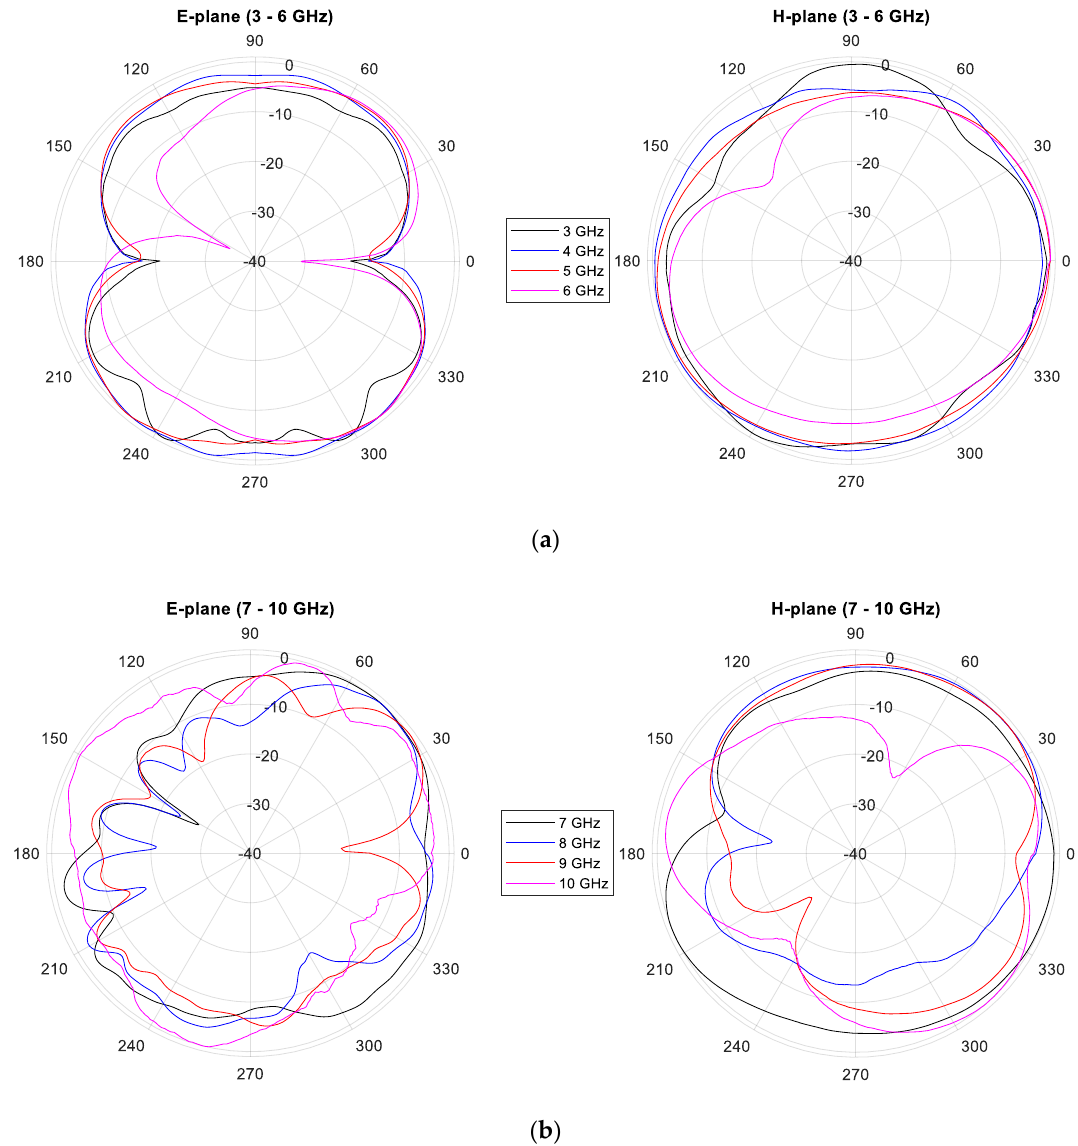
Figure 11. Measured diagram patterns for the proposed antenna: ( a ) E and H plane for 3 to 6 GHz frequency range; ( b ) E and H plane for 7 to 10 GHz frequency range.